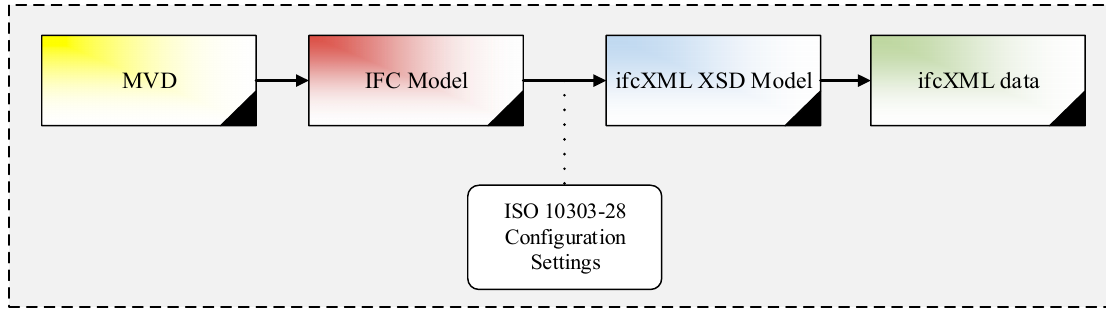
Figure 8. The general process of creating an ifcXML data file.